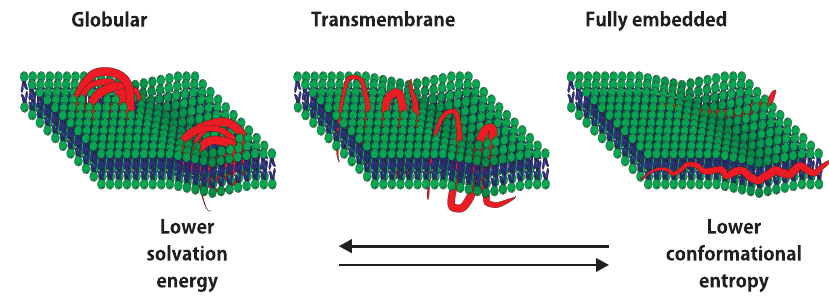
Fig. 3 Models proposed with different possible conformations for silicone oligomers and polymers in lipid membranes. Embedding of the polymer within the membrane decreases the solvation energy but is balanced by the entropic cost of uncoiling the